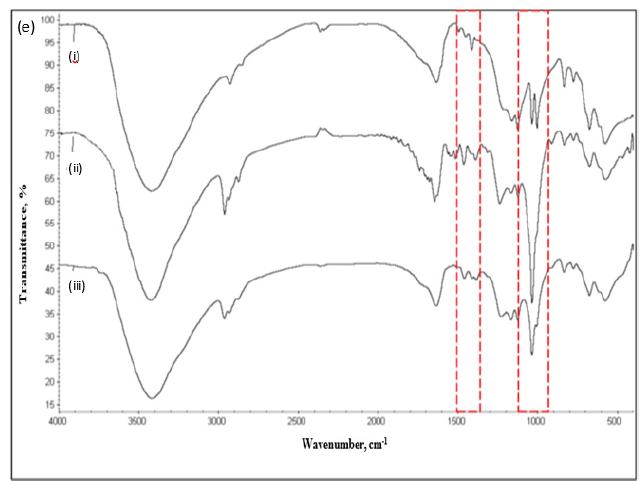
Figure 1. Scanning electron microscopic (SEM) images of raw Dowex 5WX8 polymeric resin ( a ), pristine SIR ( b, c ), RhB saturated SIR ( d ), and Fourier transform infrared (FT-IR) spectra of raw Dowex 5WX8 polymeric resin ( i ), pristine SIR ( ii ), and RhB saturated SIR ( iii ) ( e ) .